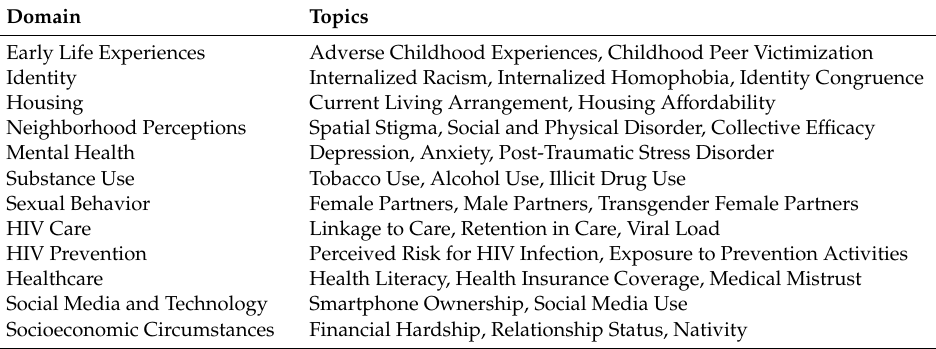
Table 1. Example Survey Constructs in the Neighborhoods and Networks (N2) Cohort Study